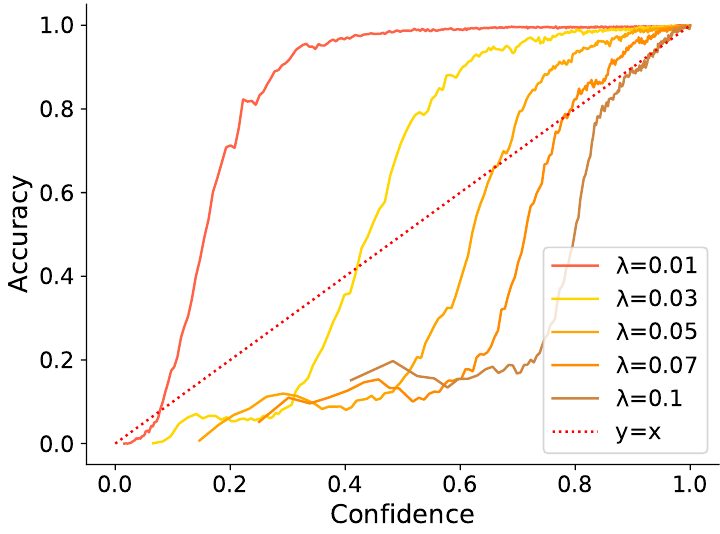
Figure 5. The accuracy of frame-level predictions changes with confidence estimates and probabilities. The values of parameter λ influence confidence-accuracy